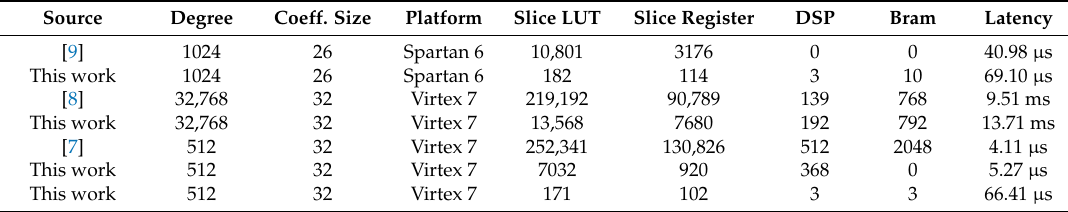
Figure 7. Flexibility with respect to published works. Table 2. Examples of performance and complexity comparisons for polynomial multiplications.